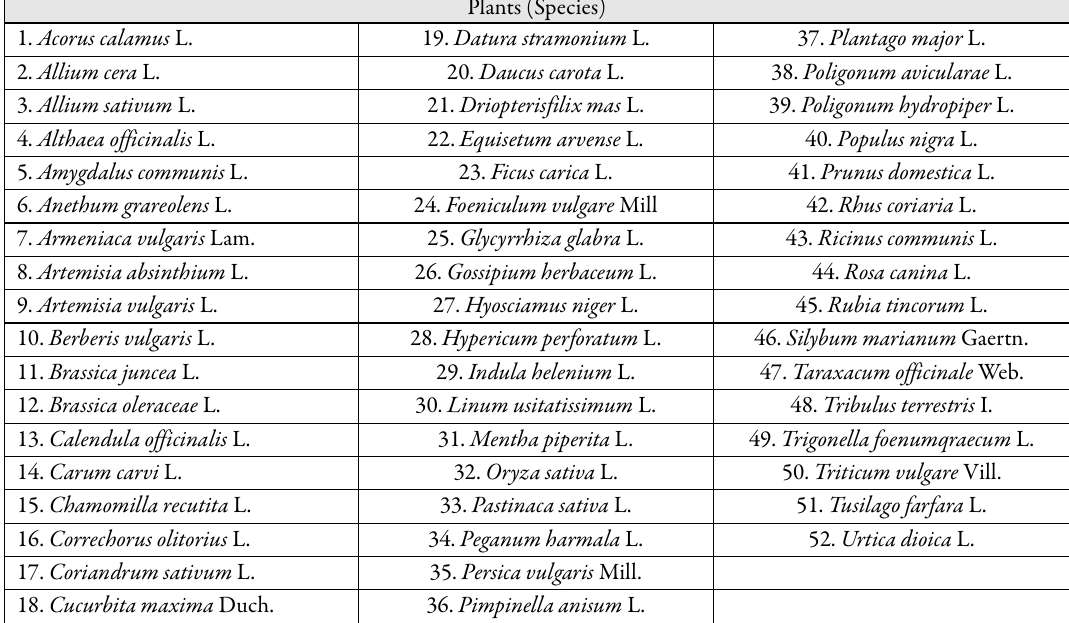
Table 8. List of herbs from the heritage of Avicenna used by scientific medicine at present (Buranova, 2015)